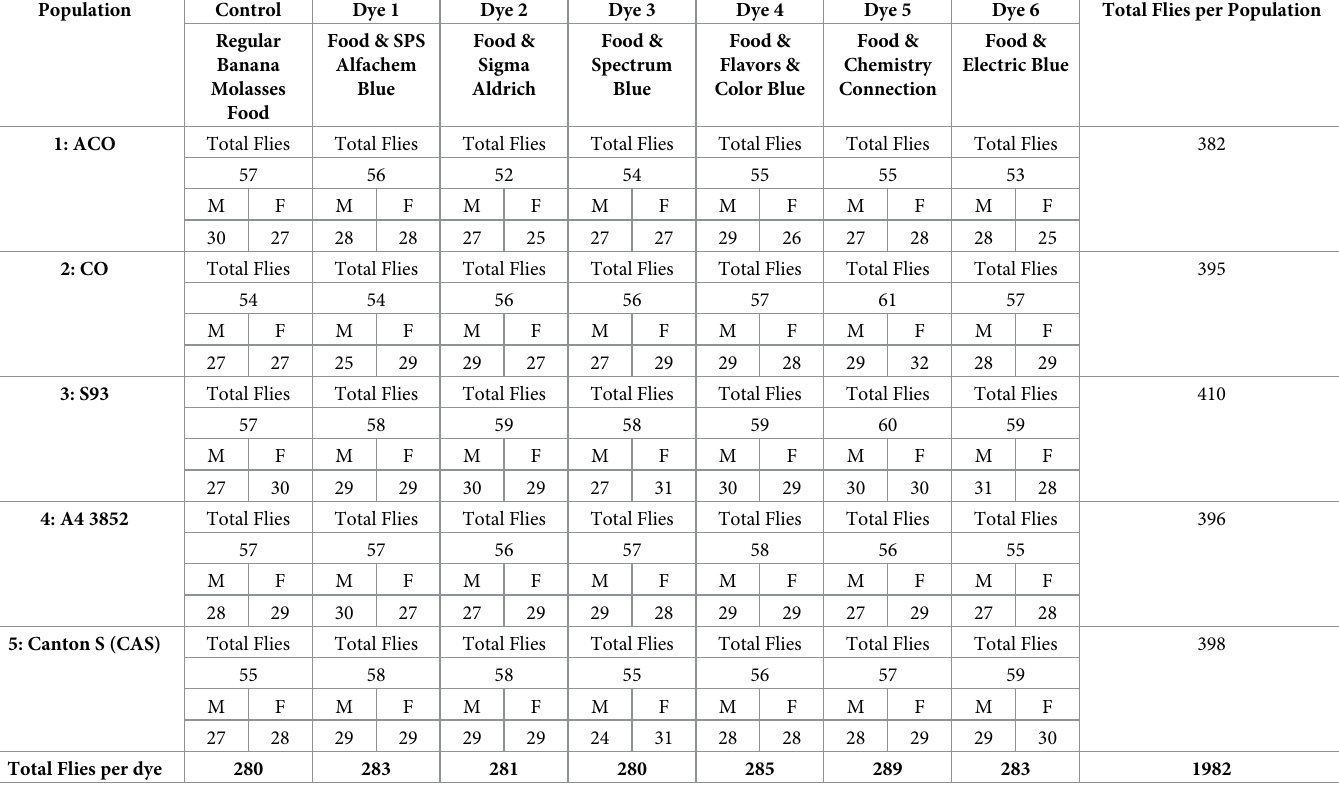
Table 1. The number of flies used in the experiment per population of D . melanogaster as well as the total number and sex (M = Male, F = Female) of flies exposed to each dye. The left column has the five populations used: ACO, CO, S93, A4 3852 and Canton S, and the top row has the medium that the flies were fed: either the con- trol banana molasses food or the banana molasses food with the indicated dye. This table excludes one CO individual in dye 1 whose sex was